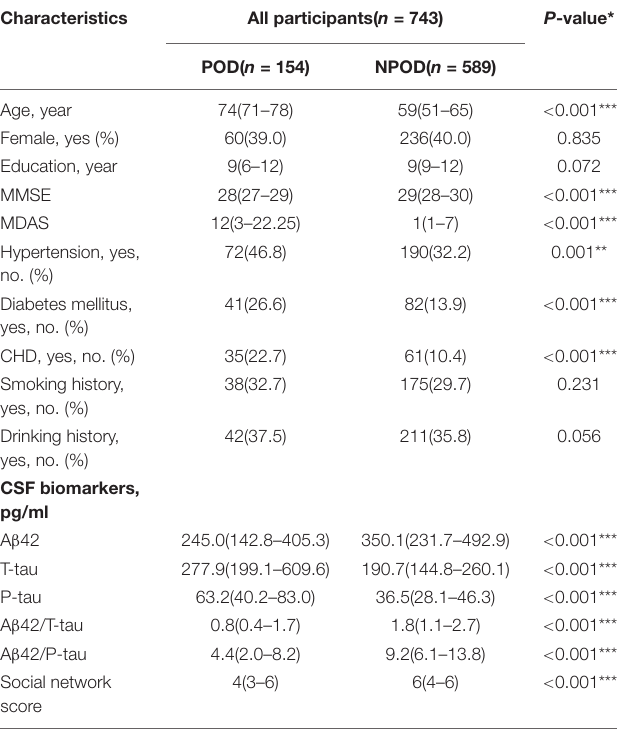
TABLE 1 | Characteristics of included participants in PNDABLE database.